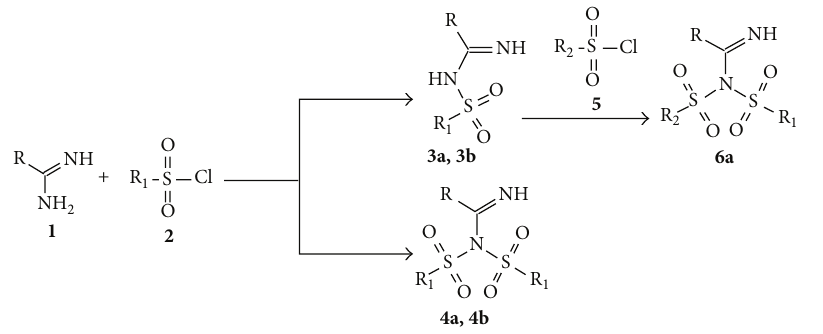
Scheme 1: Amidine sulfonamides.